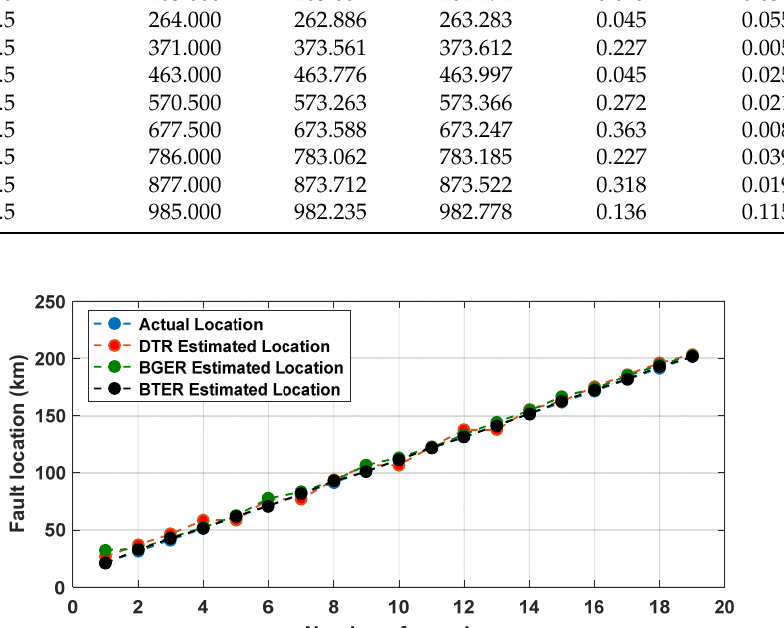
Table 6. Actual and estimated fault location for double pole to ground